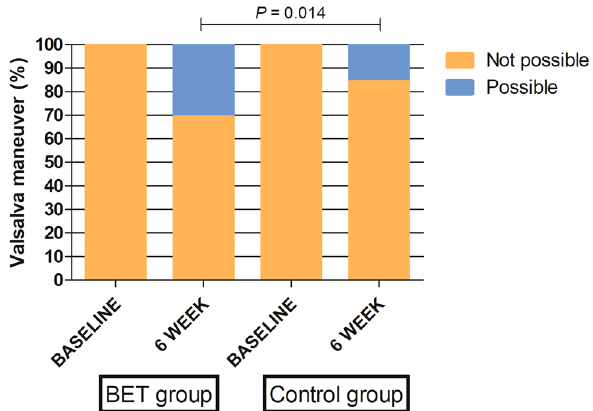
Figure 4. Changes in the positive modified Valsalva maneuver preoperatively and at 6 weeks